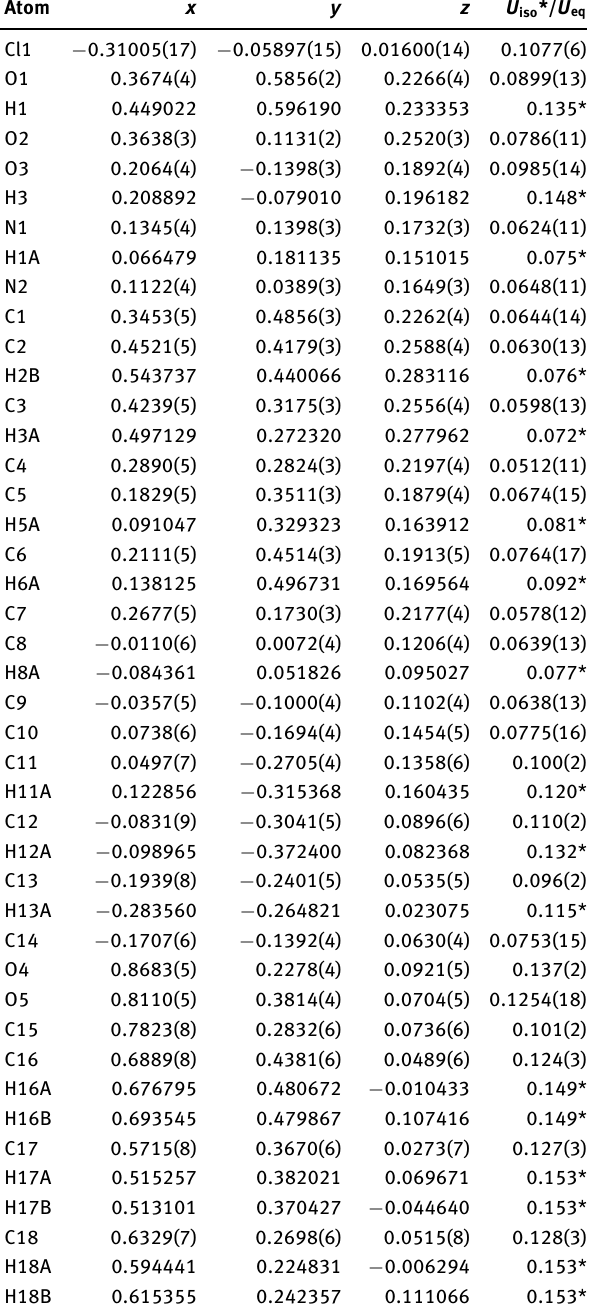
Table 2: Fractional atomic coordinates and isotropic or equivalent isotropic displacement parameters (Å 2